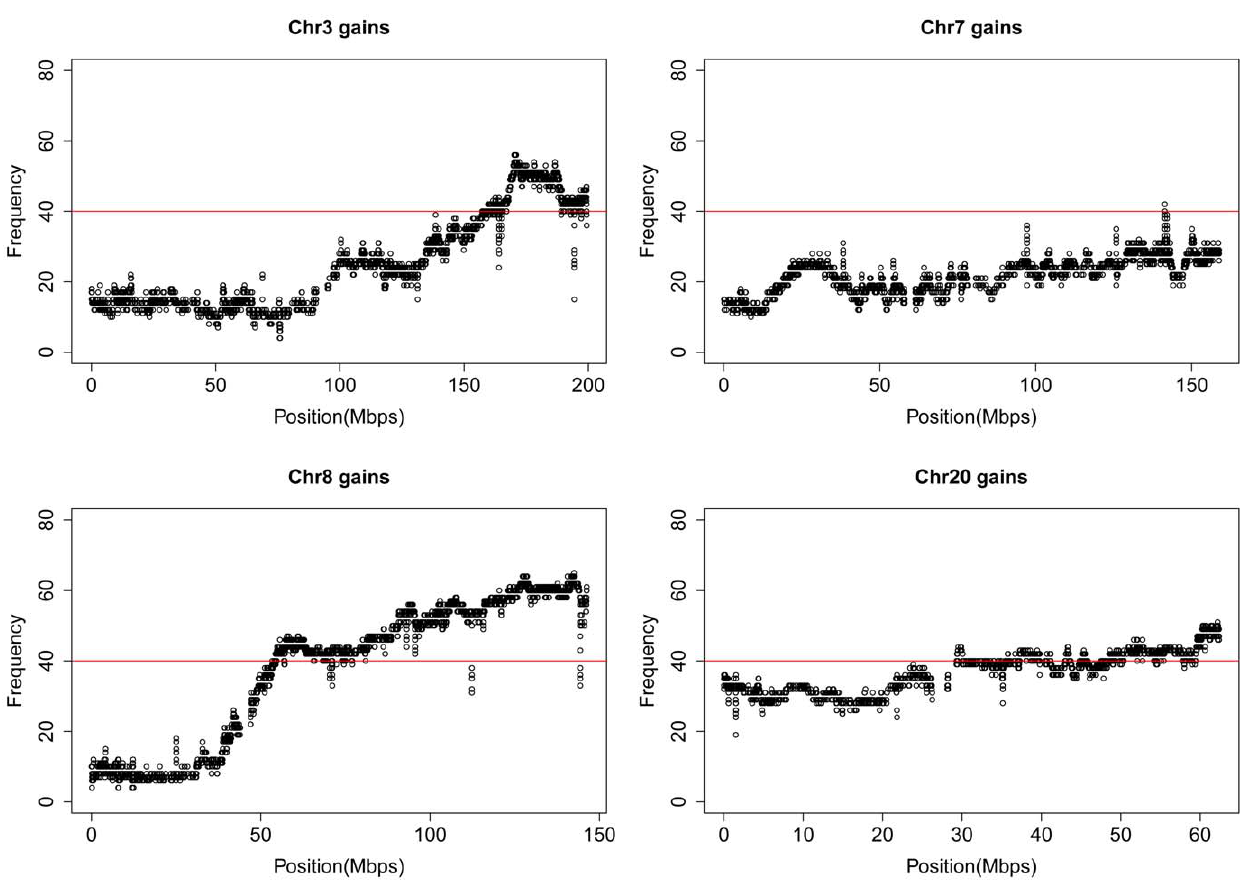
Figure 2. Detailed view of chromosomes showing frequent gains. Frequent gains occur on chromosomes 3, 7, 8 and 20, with each point indicating the frequency of gain of a CN segment. The red line in all panels indicates the 40% frequency threshold.